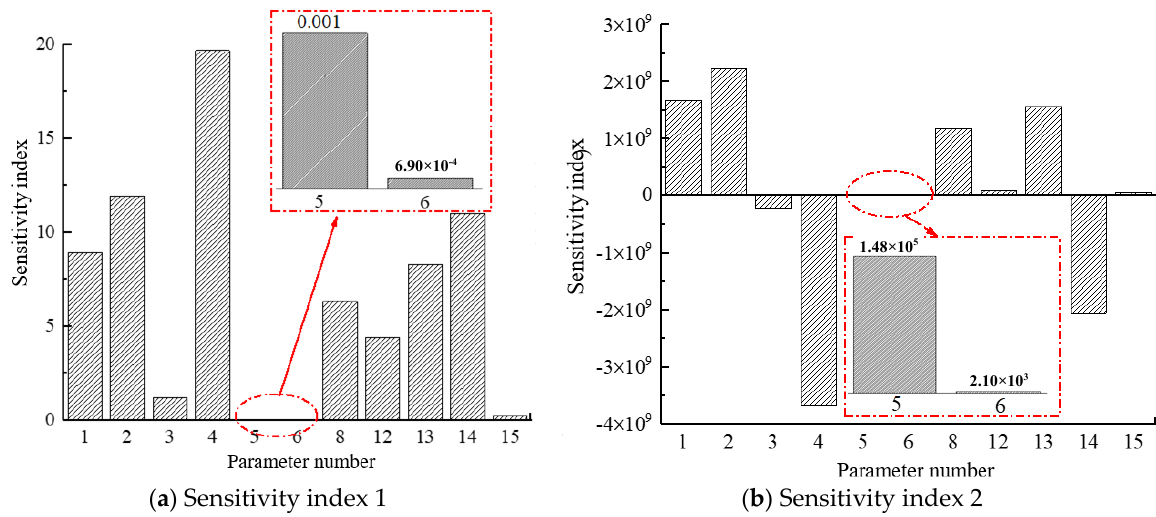
Figure 12. The sensitivity index resulting from amplifier parameter variation.